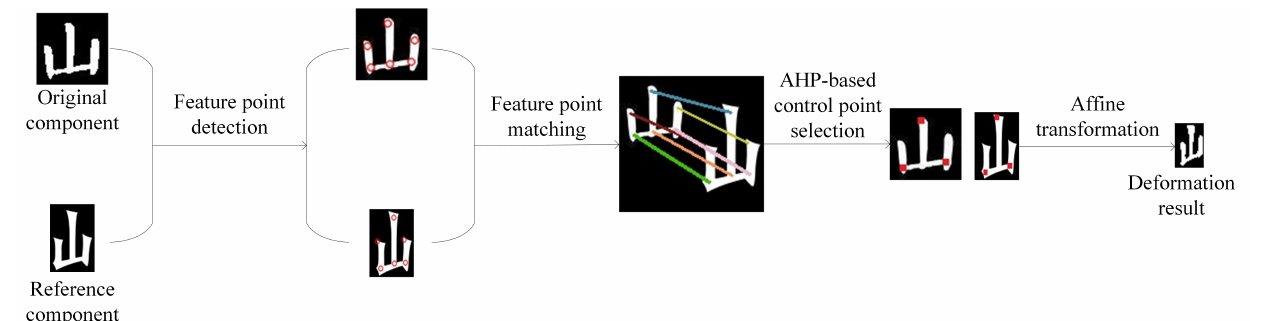
Figure 2. The overall procedure of our experiment. The input consists of an original component image and a reference component image. The original component is a handwritten font, and the reference component is a regular print font that provides a reference for the deformation of the original component. The final output is a new component image that retains the original writing